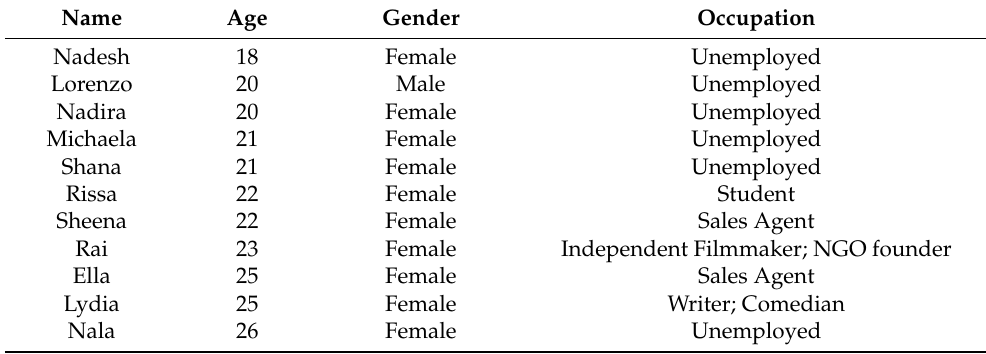
Table 1. Participant